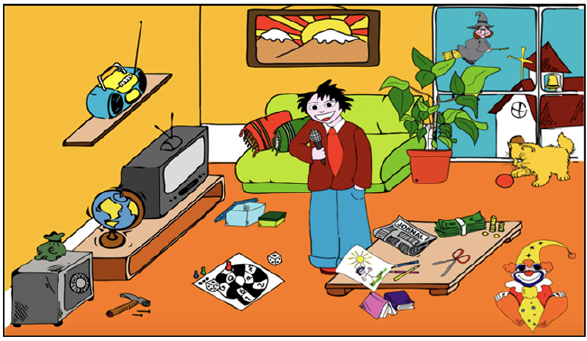
Figure A1. Thematic picture Sala ‘Living Room’.